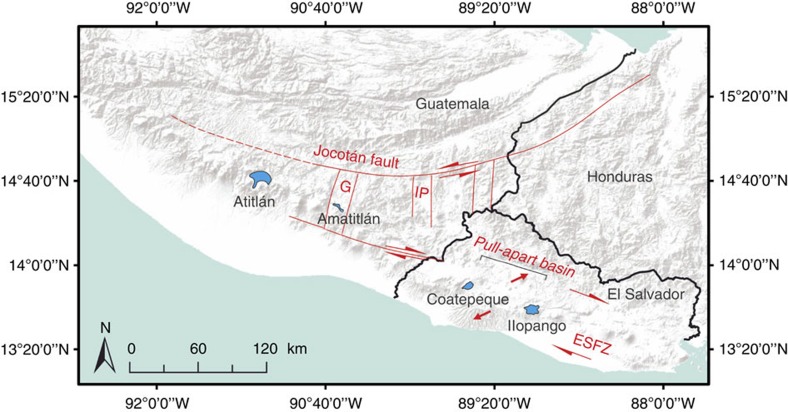
Tectonic setting of large-volume silicic calderas in El Salvador and Guatemala.The Jocotán fault is the southernmost plate boundary fault between the North American and Caribbean plates, and is the northern boundary of along-arc transtensional deformation. Modified after ref. 50. ESFZ=El Salvador Fault Zone; G, Guatemala graben; IP, Ipala graben.